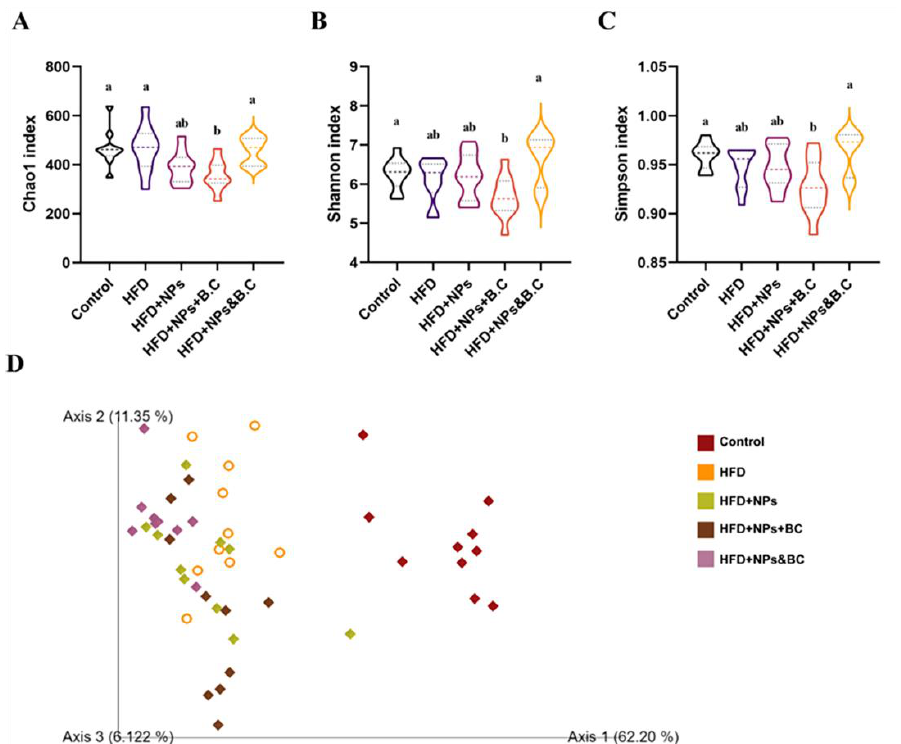
Figure 4. Alpha and beta diversity of gut microbiota. The ( A ) Chao1 index, ( B ) Shannon index, ( C ) Simpson index, and ( D ) PCA score plot of each group. The different letters represent significant differences among groups ( p < 0.05).